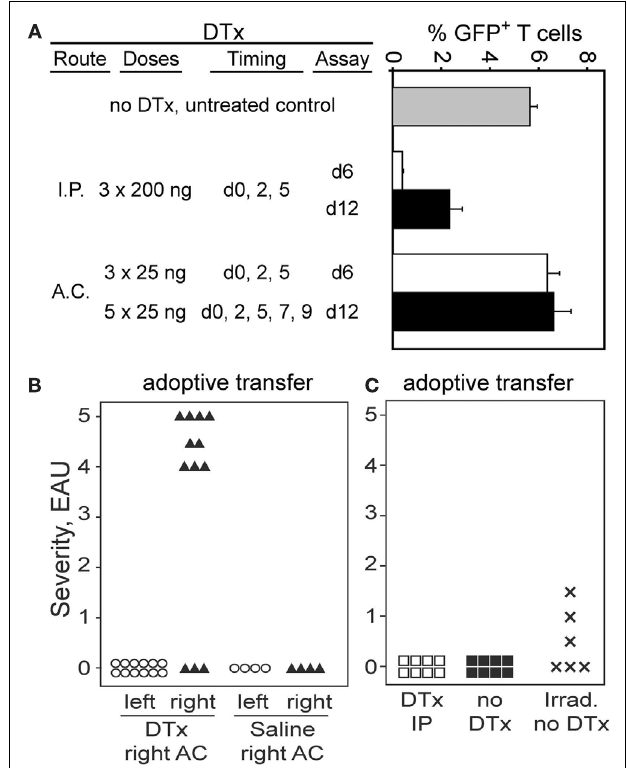
FIGURE 6 |Administration of DTx into the eye reveals that locally producedTregs are responsible for protection of the retina from EAU. (A) Administration of DTx to Foxp3-DTR/GFP mice by the AC route does not depleteTregs systemically. Graph shows% GFP + T cells in the fraction of CD3 + 4 + T cells in blood. (B) Transfer of activated BG1 × Foxp3-DTR/GFPT cells into Foxp3-DTR/GFP × arr β gal recipients, combined with local, unilateral depletion ofTregs leads to EAU in the depleted retina. Severe EAU was induced in retinas of eyes depleted ofTregs, but not in the contralateral retinas of the same animals. Control mice received an equal volume of saline in the AC. Mice were harvested 23days post-transfer. Average EAU in all DTx treated eyes = 3.4 ± 2.1. (C) Systemic treatment with DTx did not promote EAU induction. Mice (Foxp3-DTR/GFP × arr β gal) were treated with 250ng DTx on days 0, 3, and 6.T cells from BG1 mice lacking the Foxp3-DTR transgene were activated with Ag in vitro , and 7.5 × 10 6 T cells transferred on day 7. Control mice were not DTx treated, or were given radiation to induce lymphopenia, which promotes pathogenesis of EAU. DTx treatment given i.p. reduced the frequency of GFP + Tregs in blood from 3.6 to 0.4% 1day after the last